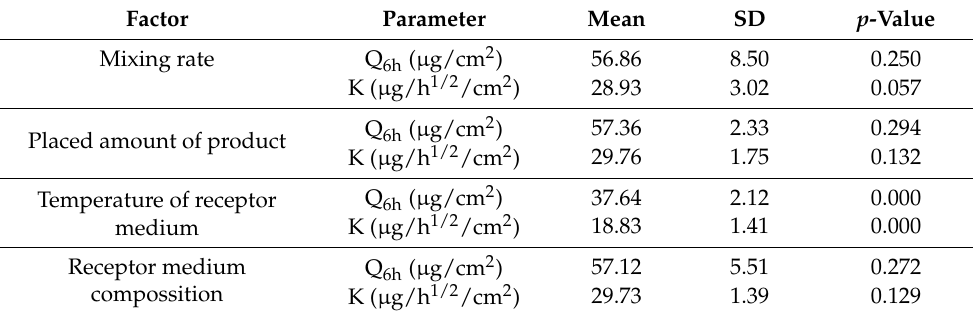
Table 6. Release parameters (released amount of capsaicin at 6 h (Q 6h ) and release constant (K)) values after the modification of operational parameters. SD: standard deviation.